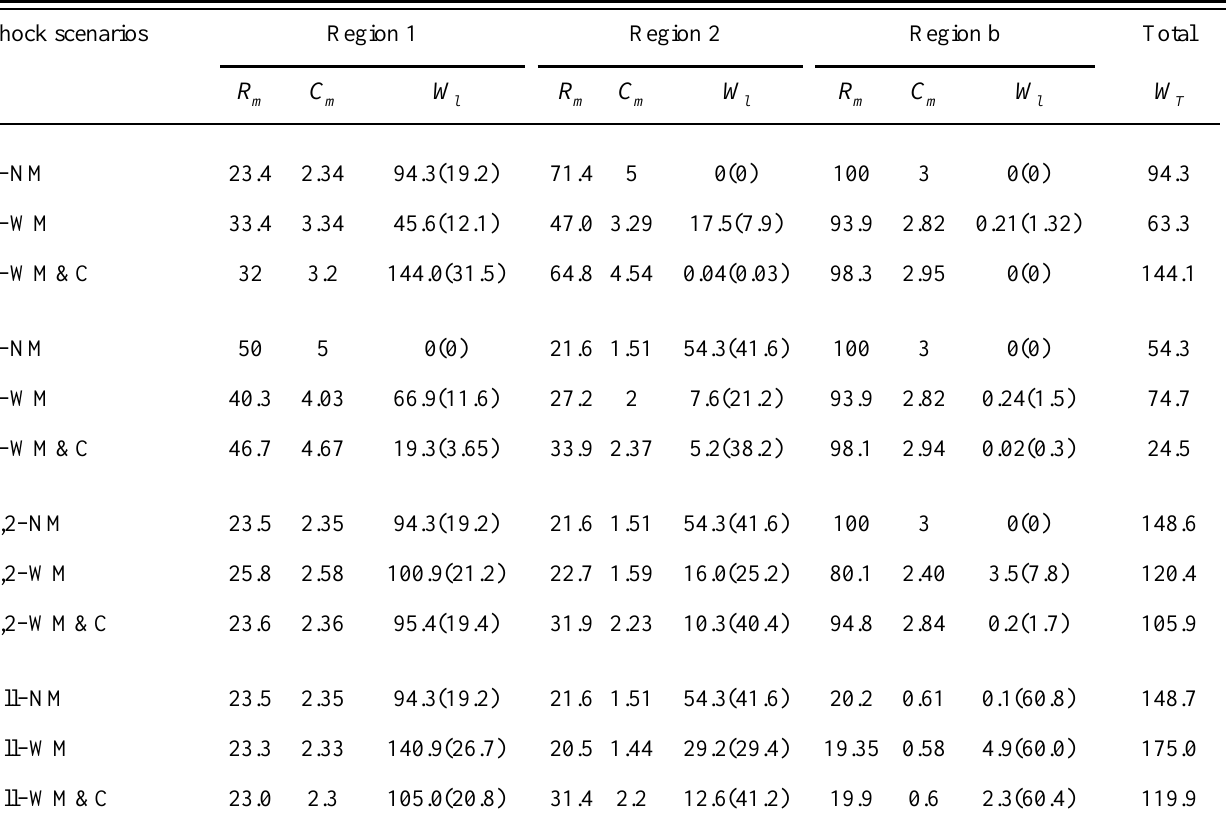
Table 3 . Summary of system response to shocks. R levels reached during the shock, respectively. W shock in each region (per capita shown in parenthesis), and W three regions, i.e., the quantity defined by Equation 14. NM = no migration, WM = with migration, WM&C = with migration and cultural (social)